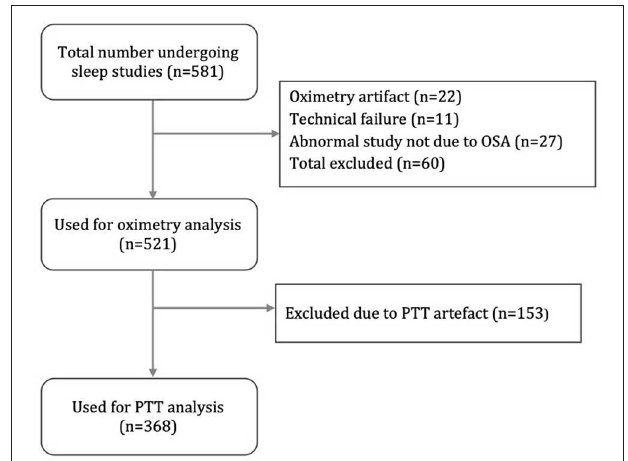
FIGURE 4 | Flow diagram of study